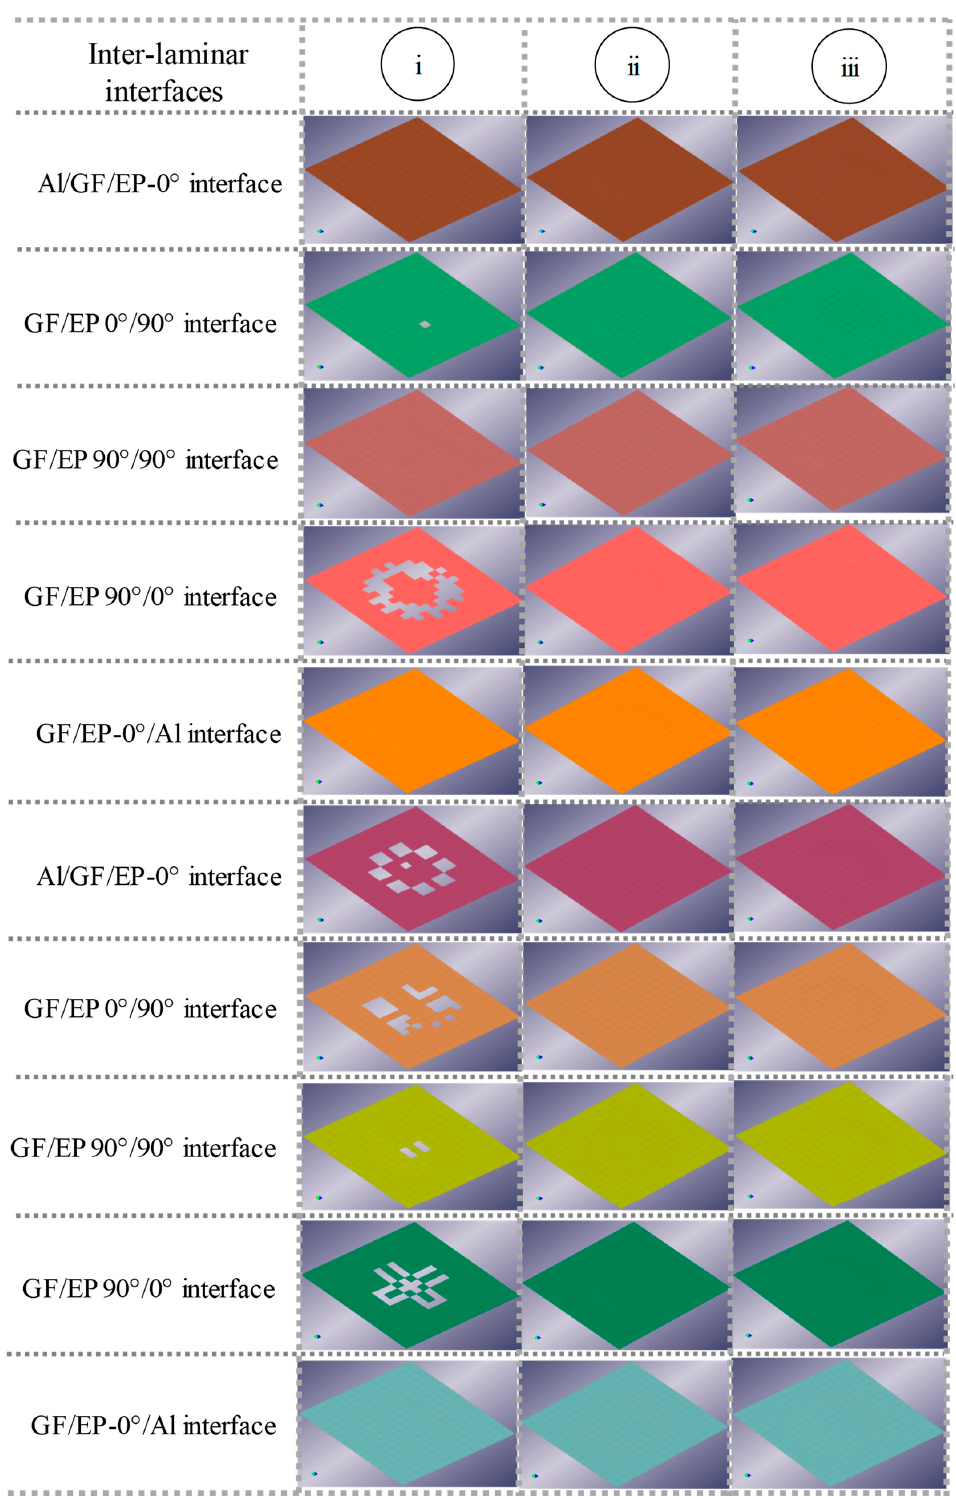
Figure 8. Debonding and delamination of cohesive interfaces of the GLARE laminate ( i ) at room temperature, ( ii ) at 80 ◦ C (39% tougher epoxy-FM94), and ( iii ) at 80 ◦ C (45% tougher epoxy-FM94) at 0.099 ms; the cohesive interfaces are organized from the impacted (top) to the non-impacted (bottom) side.